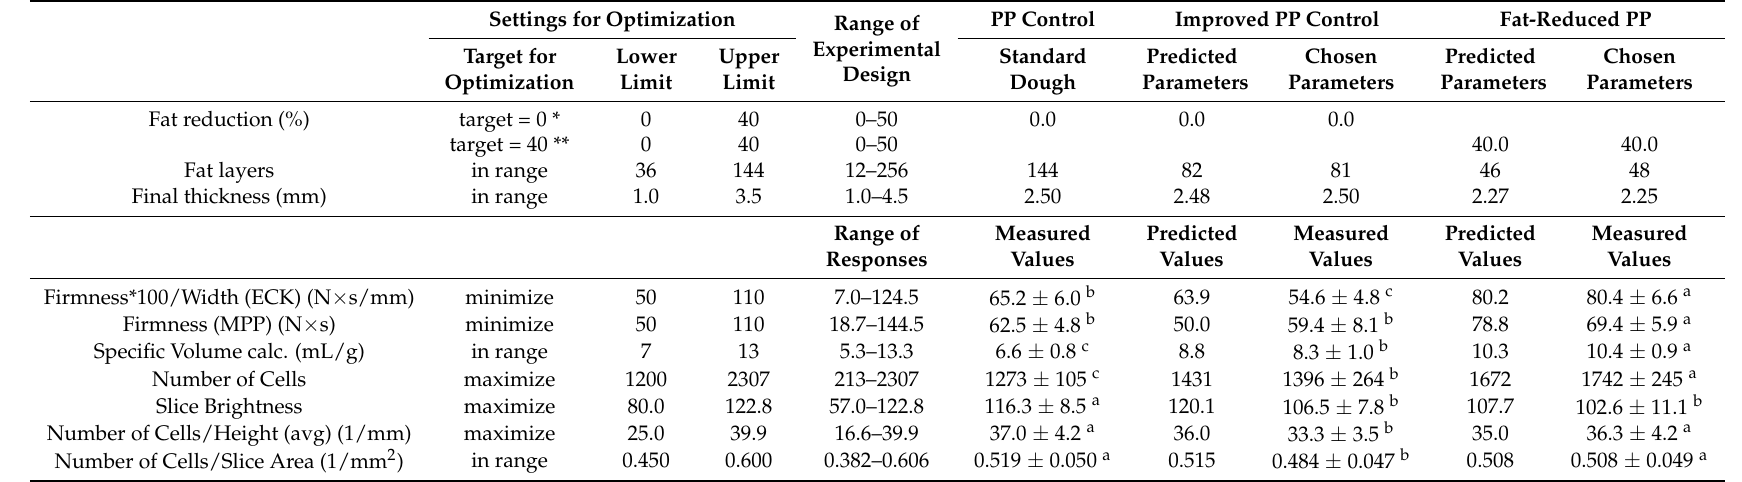
Table 4. Optimum ranges for independent parameters and predicted (by Response Surface Methodology) and measured values for the responses of puff pastry (PP) at 0% and 40% fat